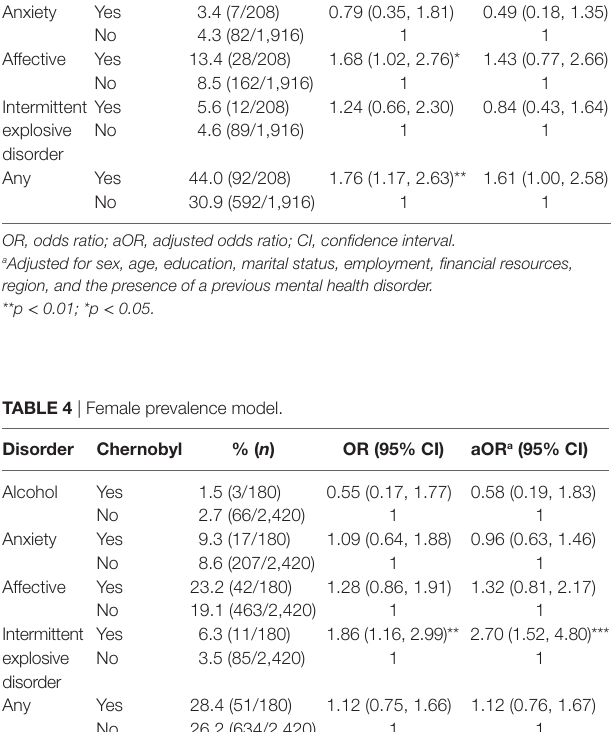
explosive disorder